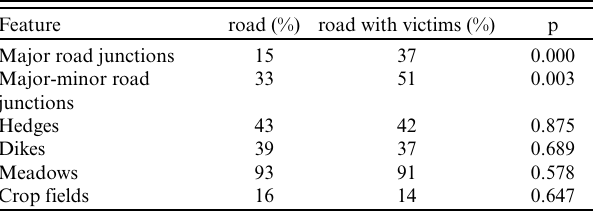
Table 2 . Percentages of road sections with a particular feature within the total number of road sections and among road sections at which at least one owl was found dead. Only major road junctions and junctions between major and minor roads stand out as death traps for Barn Owls ( Tyto alba